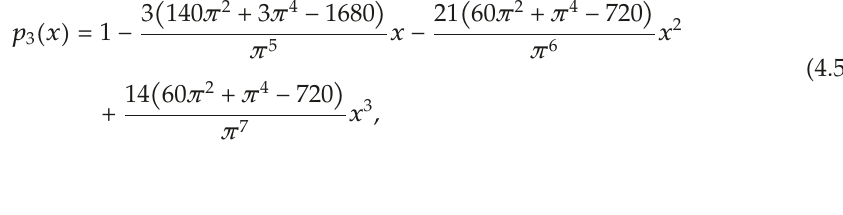
, green dash line by (cid:5) sinc (cid:2) x (cid:6) − p r sinc (cid:2) x (cid:6) − p l 3